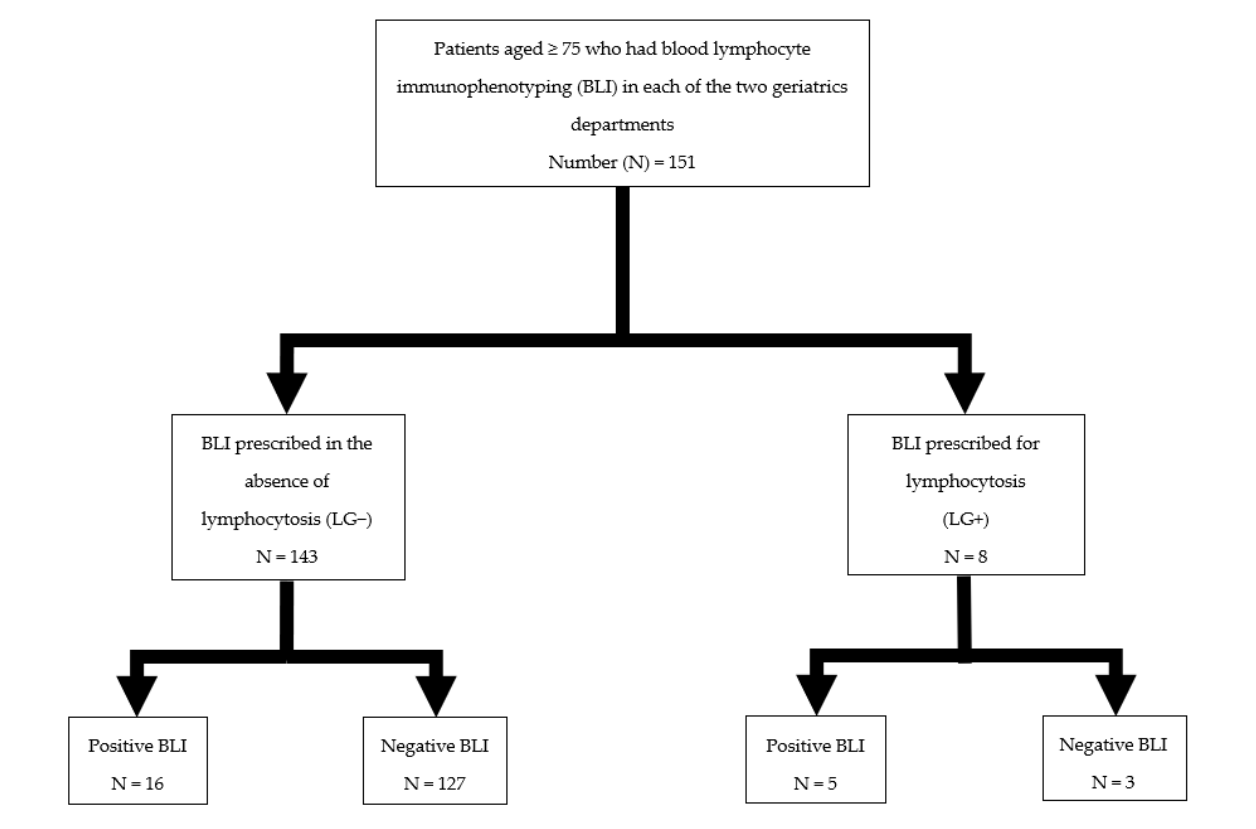
Figure 1. Study flowchart.